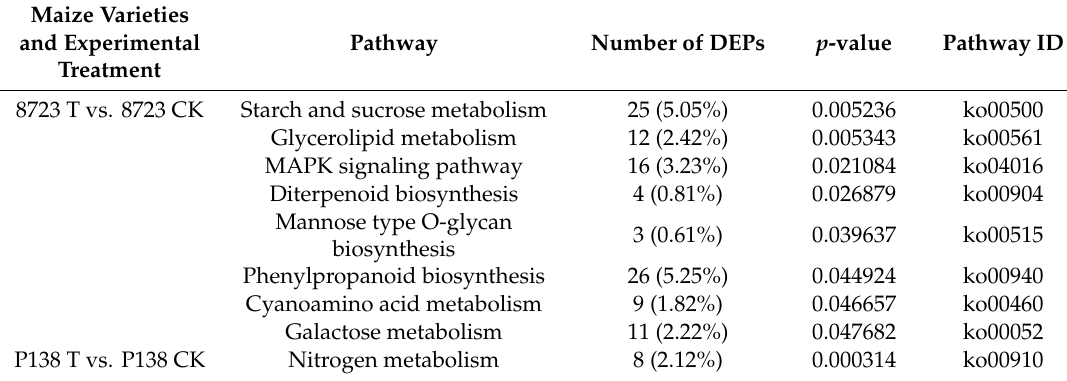
Table 1. Significant pathway enrichment analysis of di ff erentially expressed proteins (DEPs) in 8723 and P138 ( p <